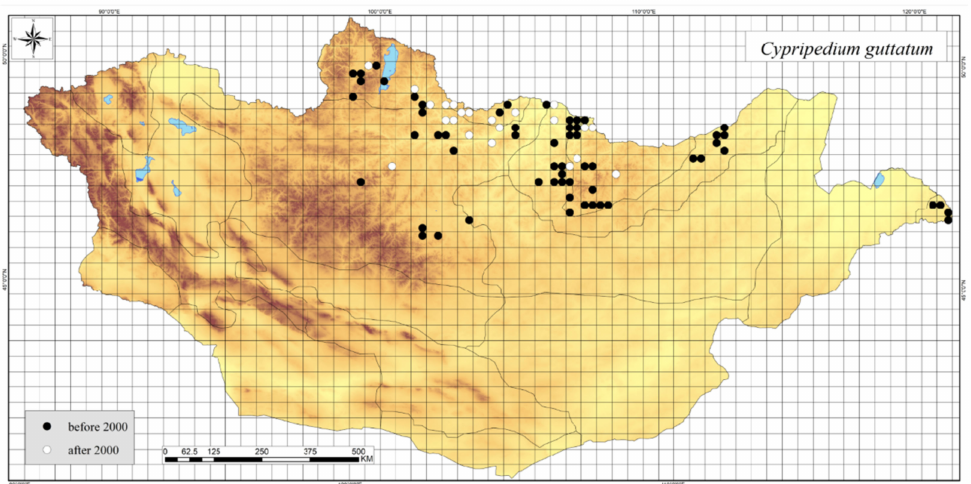
Figure A4. Distribution map of Cypripedium guttatum in Mongolia.